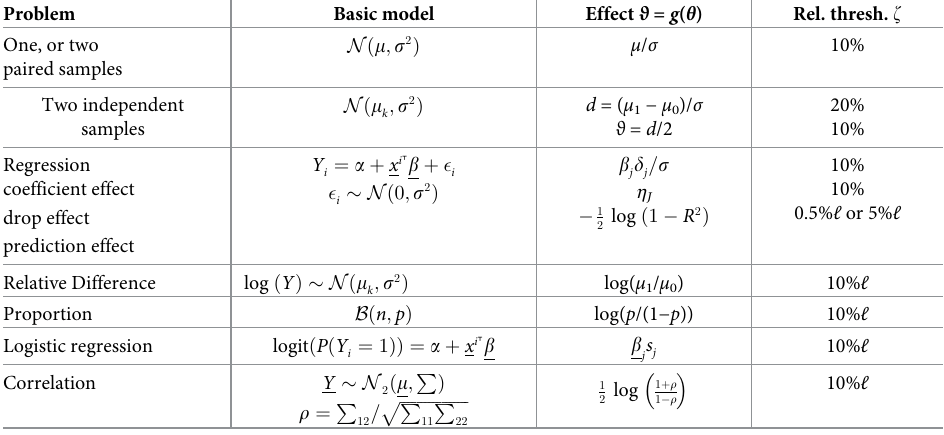
Table 2. Models, recommended effect scales and relevance